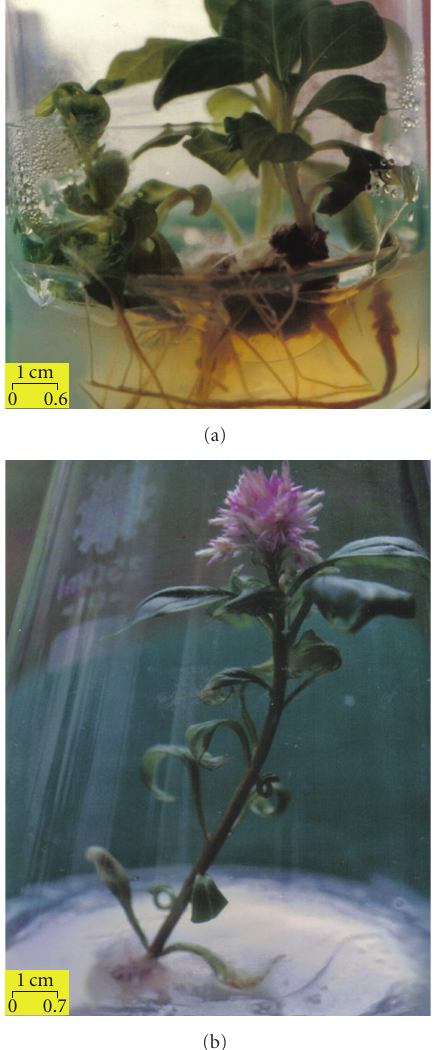
Figure 1: (a) Complete in vitro plant regeneration of Celosia cristata derived from a shoot explant cultured in MS basal medium after 35 days of culture. (b) In vitro flowering of Celosia cristata in MS basal medium after 2 months of culture at 25 ± 1 ◦ C under 12 h light and 12h dark.